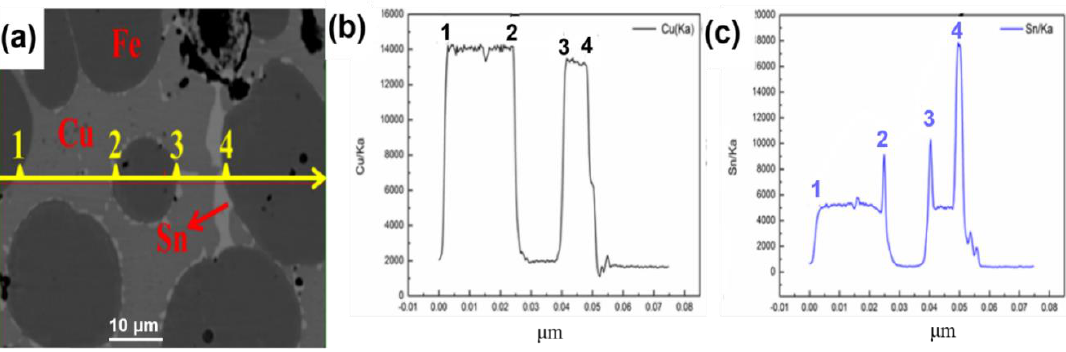
Figure 9. EPMA line scan analysis of the sample by microwave sintered at 880 ◦ C: ( a ) EPMA image, ( b ) Cu content change, ( c ) Sn content change.